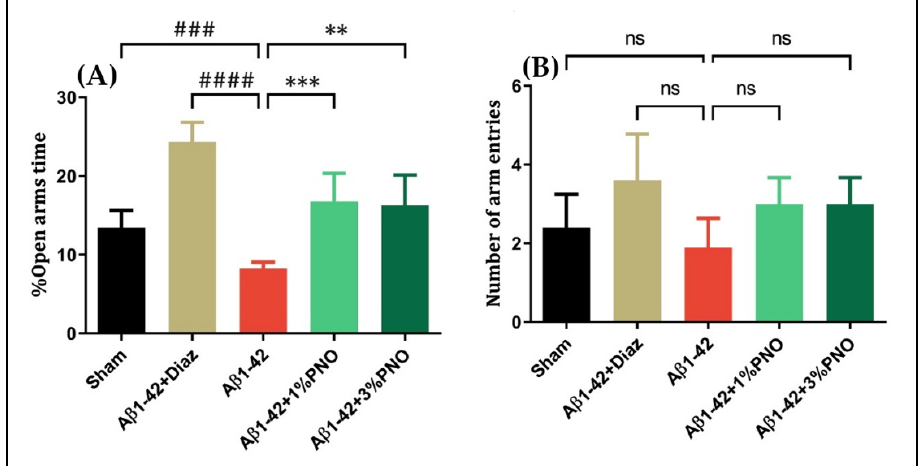
Figure 2. Effects of the inhaled Pinus halepensis essential oil (PNO, 1%, and 3%) on the anxious-like behavior in the elevated plus maze test (EPM) in the A β 1-42-treated rats. Values are means ± S.E.M. ( n = 10). ( A ) A β 1-42 vs. sham: ### p = 0.0004; A β 1-42 vs. A β 1-42 + Diaz: #### p < 0.0001; A β 1-42 vs.